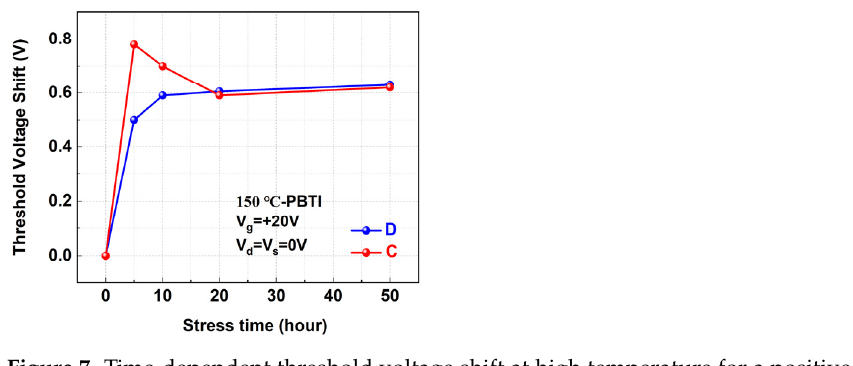
Figure 7. Time-dependent threshold voltage shift at high temperature for a positive bias-stress of +20 V. PBTI (positive bias temperature instability) has been measured at 150 °C.